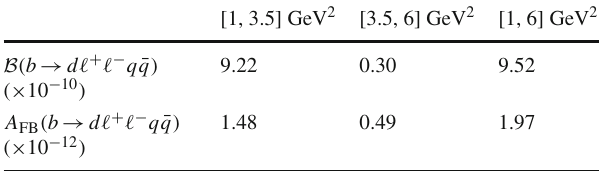
Table 2 Numerical estimates for the branching ratio and the forward- backward asymmetry of b → s (cid:2) + (cid:2) − q ¯ q in the low- q 2